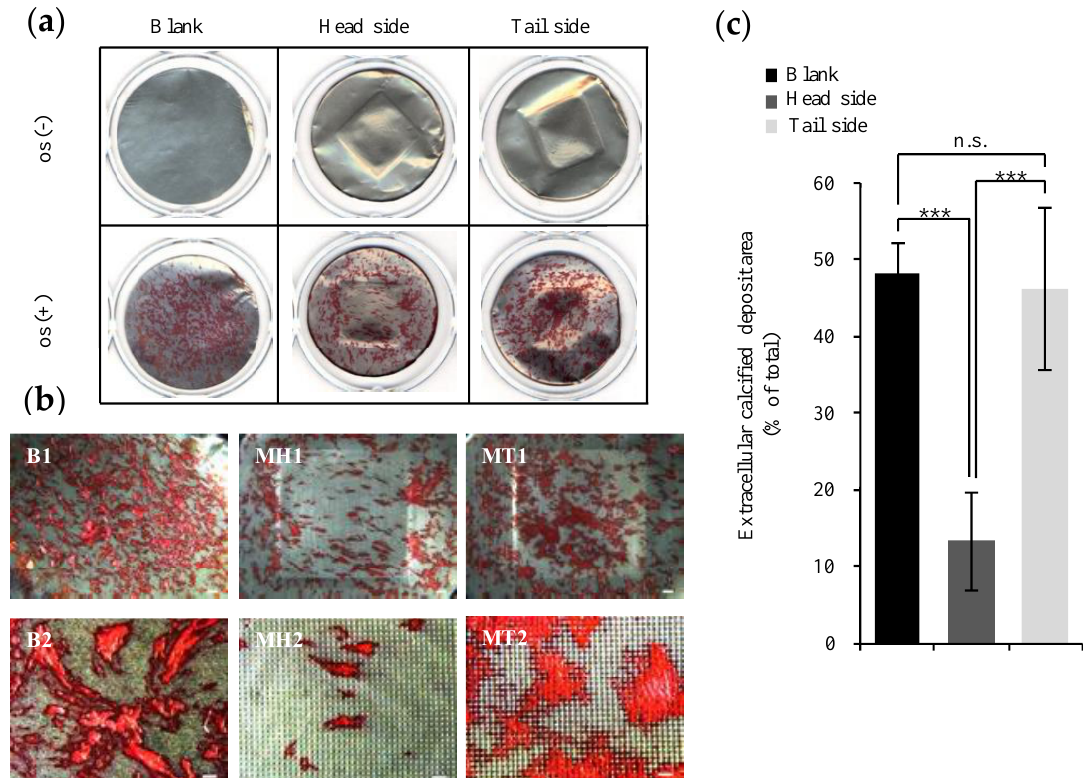
Figure 8. Calcification of osteoblasts on specimens after a 28 day induction of osteogenic differentiation. ( a ) Calcified deposits stained with ARS solution. ( b ) Surface appearance of calcified deposits on specimens using a biological microscope. A lower magnification view of calcified deposits (B1, MH1, and MT1). Scale bar represents 1000 μm. A high magnification view of calcification (B2, MH2, and MT2). Scale bar represents 250 μm. ( c ) Proportion of the calcified area in the microporous section of specimen (blank group as control). All points were calculated by Image-Pro Plus. Calcified deposits stained crimson. All values are shown as the mean ± standard deviation ( n ≥ 3). All results were compared by a one-way ANOVA with Tukey’s test using SPSS Statistics 17. Results with p values < 0.05 were deemed to be significant (*** p < 0.001); n.s., non-significant ( p > 0.05).